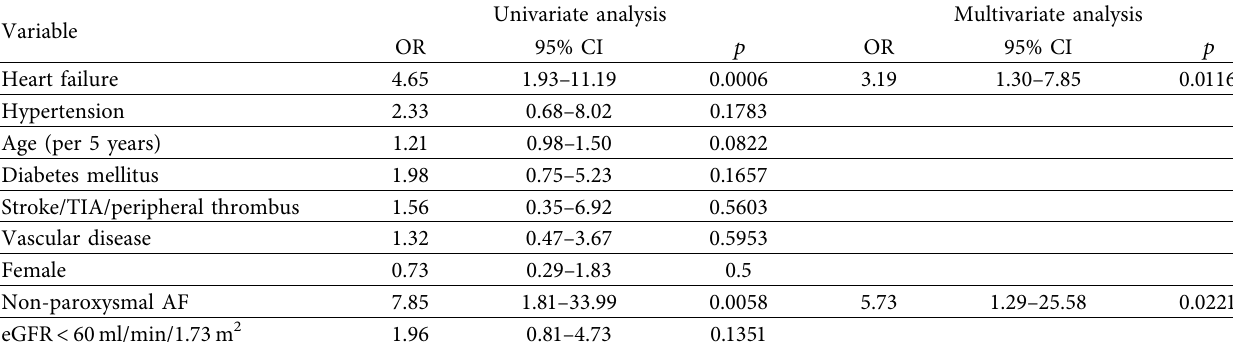
Table 5: Univariate and multivariate analysis of predictive factors for LAAT in patients treated with rivaroxaban. Variable